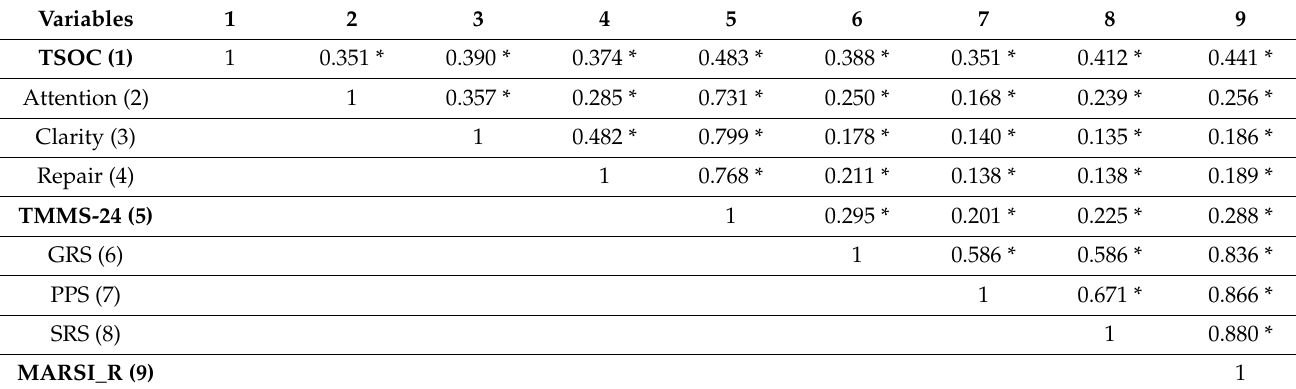
Table 2. TSOC Correlations with the TMMS-24 and